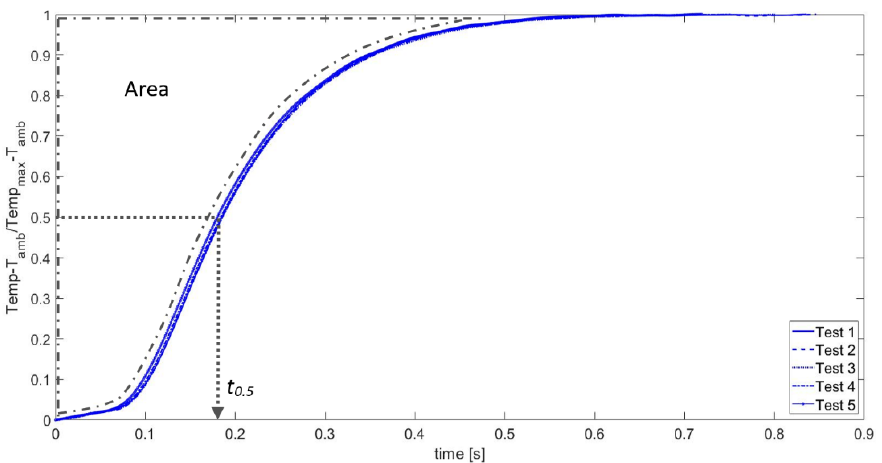
Figure 11. Inconel 601: normalized temperature rises and Standard parameters [15,17]. Table 2 resumes all results related to the thermal characterization of the substrate (Inconel 601) (averaged values of all replications) by applying Standards [15,17] formula. Table 2. Inconel 601: thermal diffusivity and thermal conductivity. ISO18755 [17] ISO18555 [15]